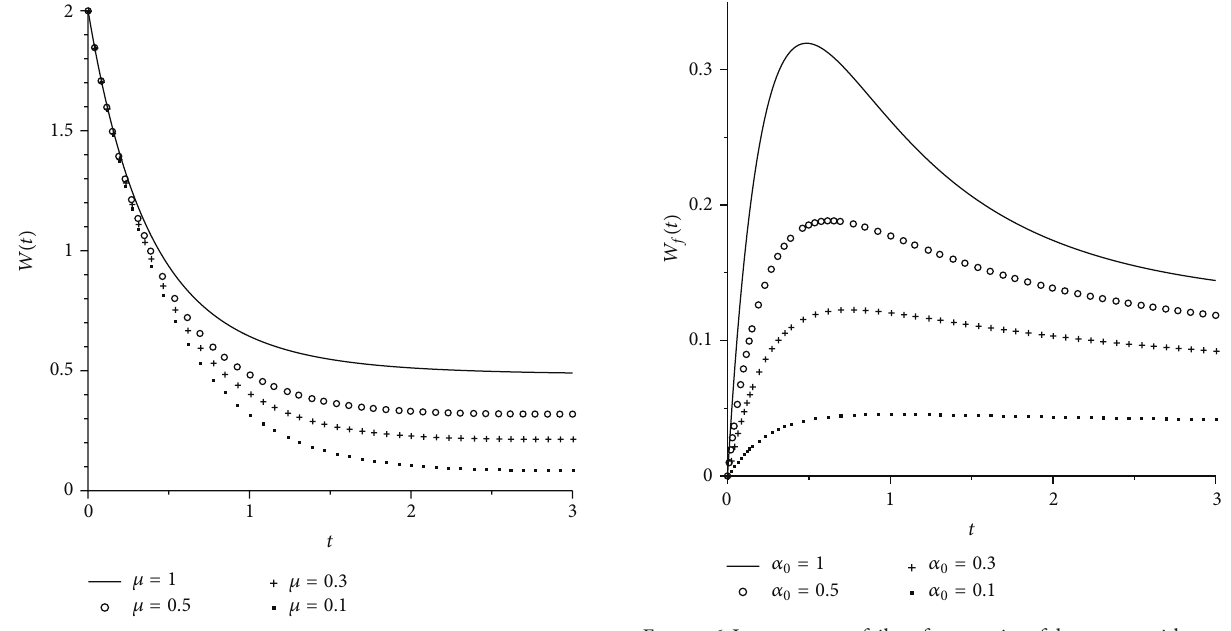
Figure 4: Instantaneous failure frequencies of the system without warning device with different 𝜇 .